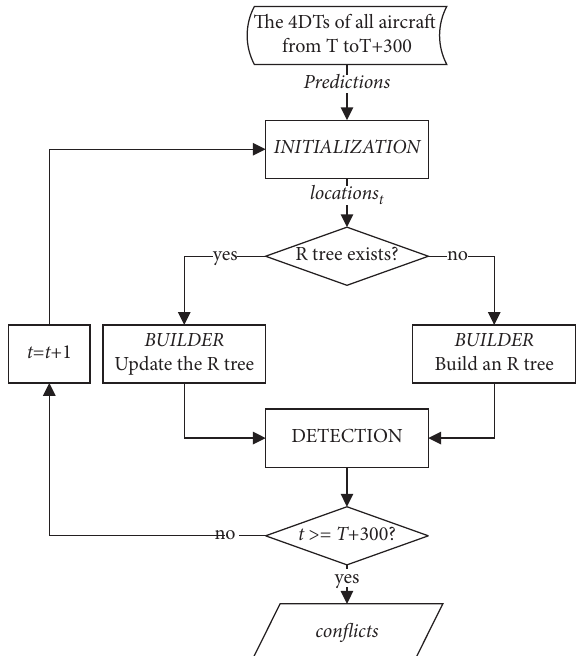
Figure 4: The flowchart of the CD algorithm based on the R